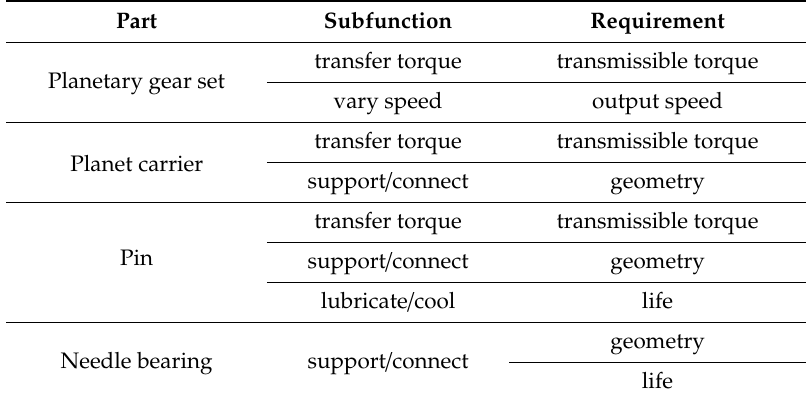
Table 3. Parts of the final reduction linked to the requirements through their subfunctions (extract).